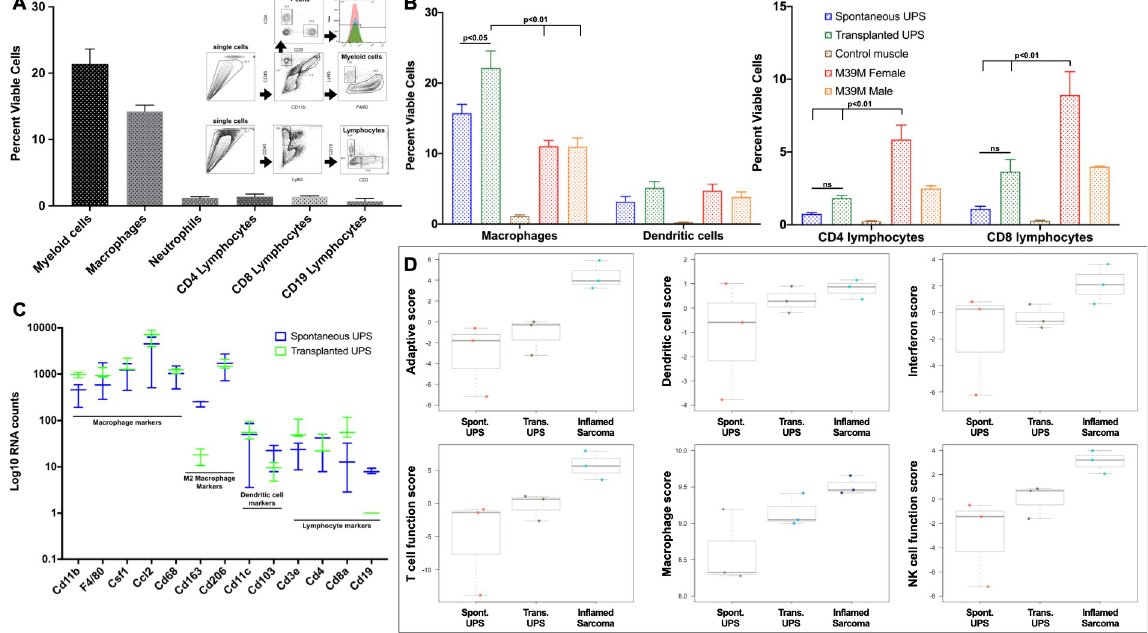
Fig 4. Spontaneous and cell line derived murine UPS tumours are macrophage rich and lymphocyte poor. (A) Using FACS analyses, macrophages are the dominant intra-tumoural immune population (14%), whereas lymphocyte numbers are low ( < 2%). (B) In a separate analysis comparing spontaneous UPS, cell lined derived (transplanted) UPS and the inflamed M3-9-M ERMS model, CD4 and CD8 lymphocyres are low (1–4%) and significantly less than the infamed M3-9-M-Female model (6–9%). The cell line UPS model is more inflamed and contains more lymphocytes than the spontaneous model, althogh these differences did not reach stastistical significance. (C-D) NanoString 1 immune profiling of UPS tumours also demonstrates high macrophage scores, and negative lymphocyte, NK cell, dendritic cell and adaptive immune pathway scores compared to an inflamed sarcoma